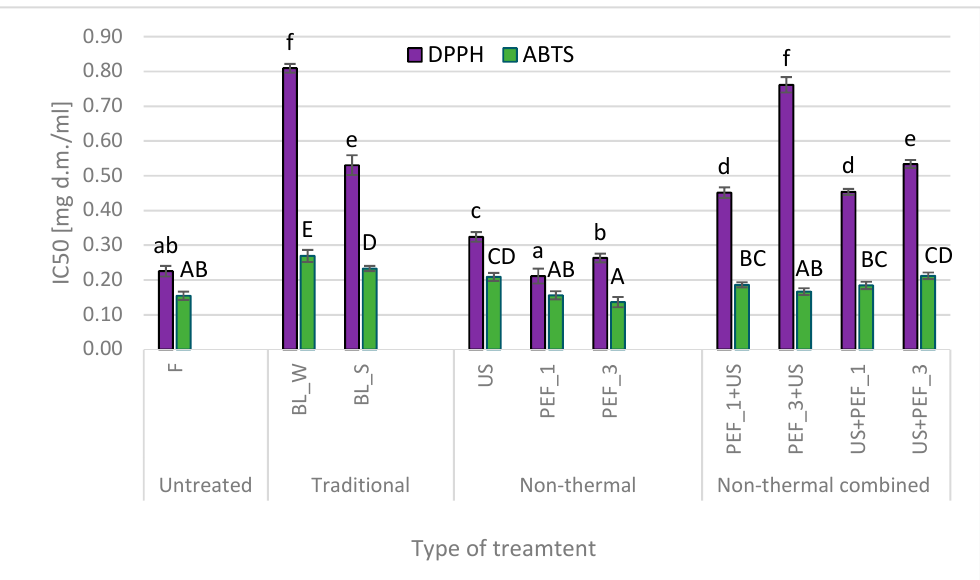
Figure 4. Antioxidant activity in fresh (F) red bell peppers and subjected to traditional (blanching in water, BL_W, and blanching in steam, BL_S) and non-thermal single treatment (US — ultrasound, PEF_1 and PE — pulsed electric field with energy input 1 and 3 kJ/kg, respectively) and combined treatment (PEF + US and US + PEF), the same letters indicate homogeneous groups (Tukey’s HSD, p < 0.05), the error bars represent the standard deviation calculated from 3 repetitions.